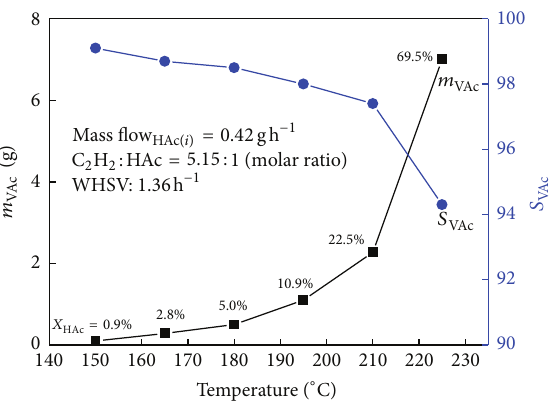
Figure 5: Effect of reaction temperature.